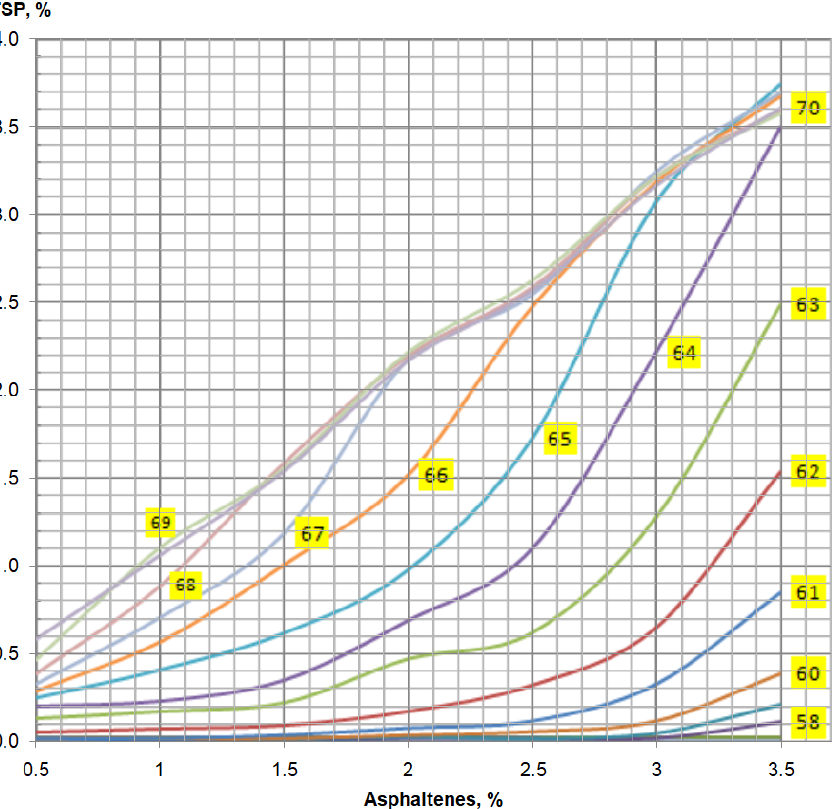
Figure 8. Nomogram of the influence of asphaltene and n-paraffin (marked with percentage) on the activity of precipitation formation.